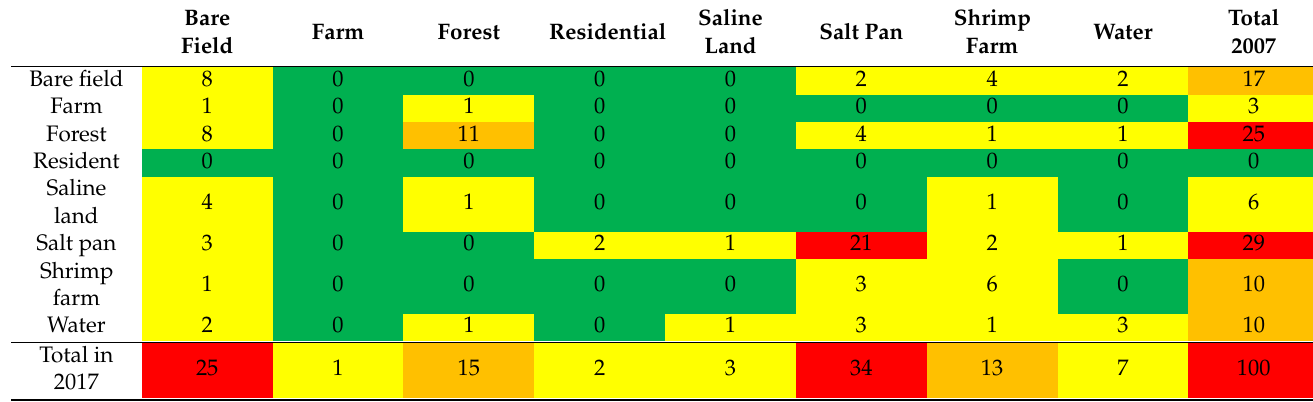
Table 5. Land use/cover change transfer matrix of the study area in P2 (percentage).